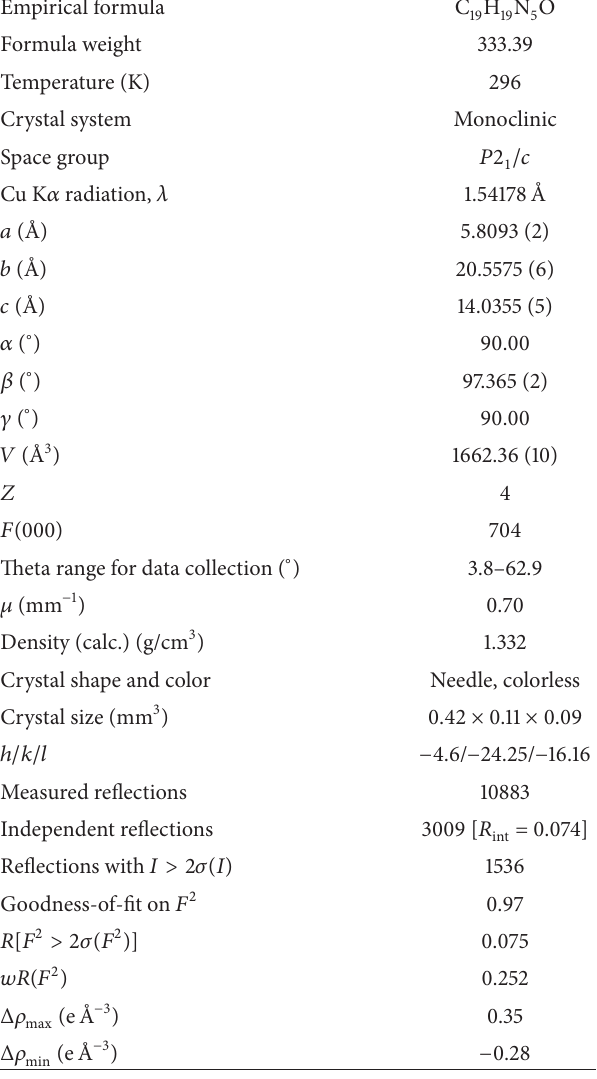
Table 1: Crystallographic data and refinement information.